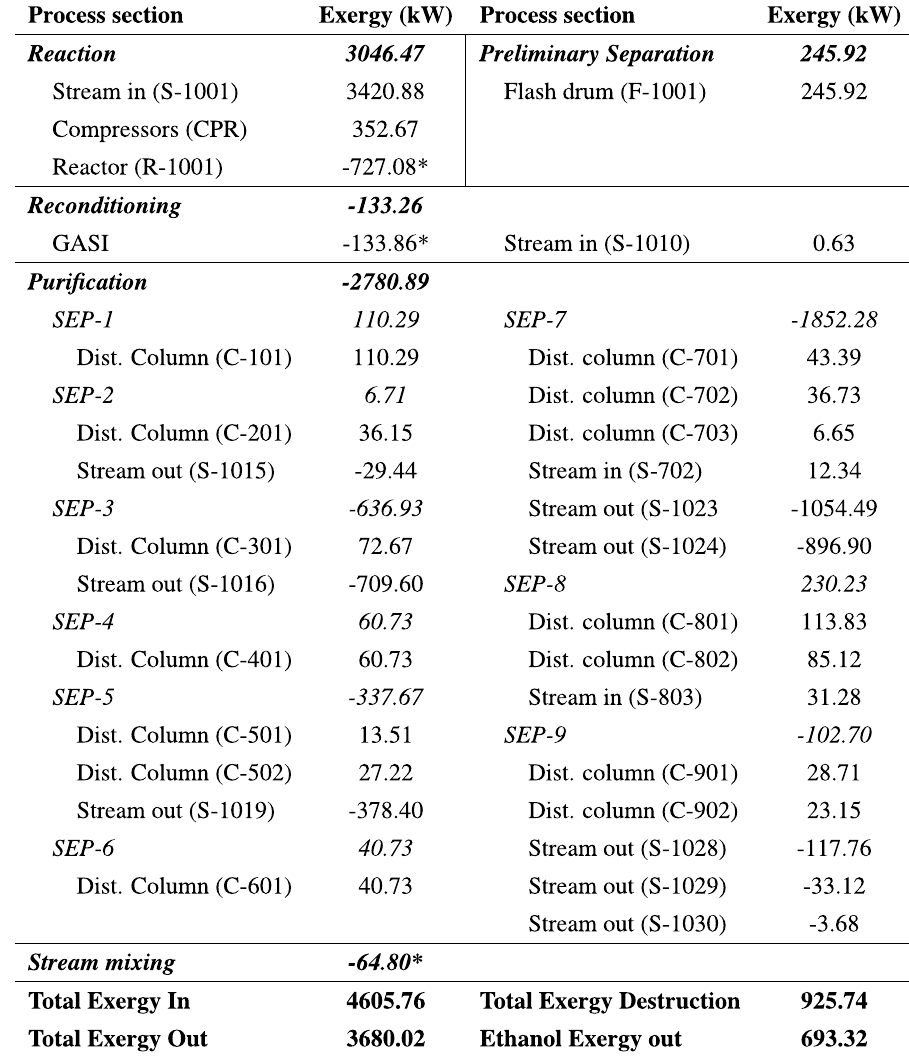
Table 3 Exergy quantification in each section of P-3